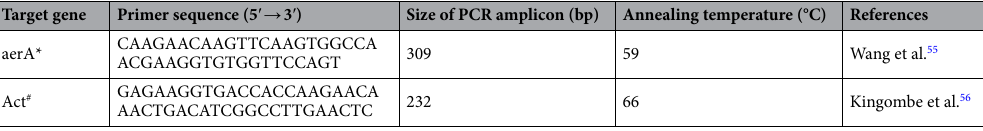
Table 4. Primers used for PCR detection of virulent genes in two bacterial isolates (AM-31 and AM-05) from naturally-infected Anabas testudineus (*Aerolysin, # Enterolysin).